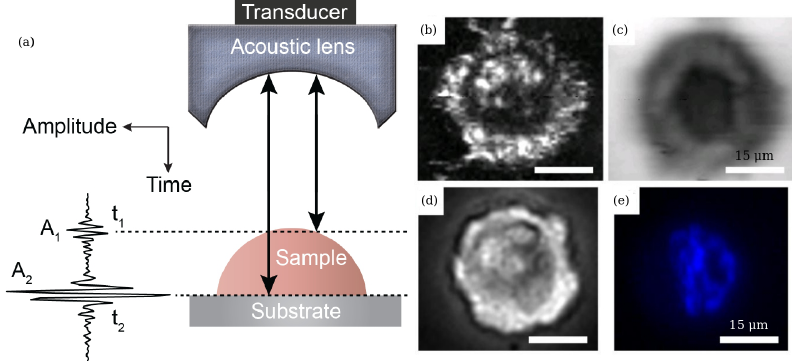
Figure 8. ( a ) Illustration of the operating principles of SAM. The acoustic echo signal with amplitude A 1 originating from the surface of the sample arrives at time t 1 . The echo signal with amplitude A 2 is reflected from the interface between the sample and its substrate and is received at time t 2 . From the arrival time of each maximum and their respective amplitudes, the elastic and mechanical parameters of the sample can be obtained. ( b ) Image of MCF-7 breast cancer cells obtained using SAM at 1GHz acoustic frequency. ( c ) Acoustic wave attenuation distribution across a cell. ( d ) Optical micrograph of a cell. ( e ) Fluorescence-based micrograph of the same MCF-7 cell, where the stained cell nucleus overlaps with the darker area in the image in panel ( c ). The scale bar in all panels corresponds to 15 µ m. Reproduced from [142] under the terms of the Creative Commons Attribution 4.0 International Public License (CC-BY